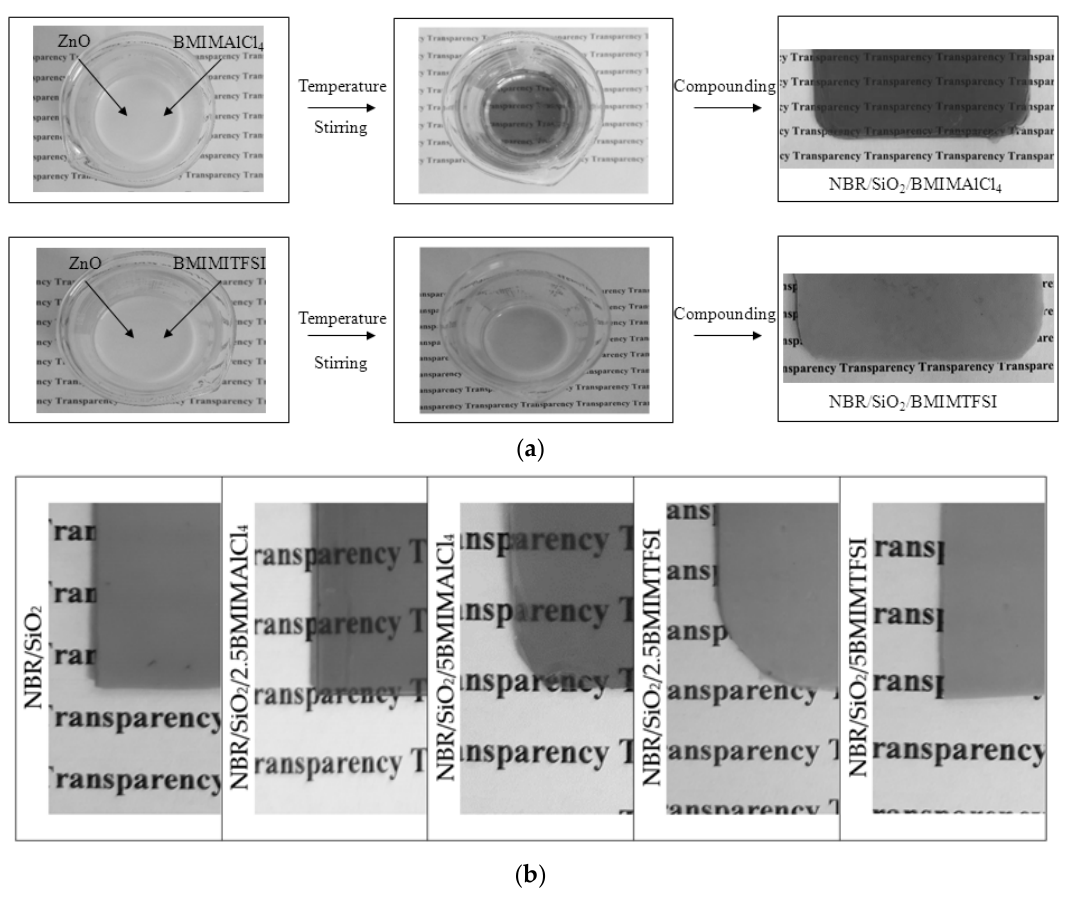
Figure 2. Effect of imidazolium ionic liquids: 1-butyl-3-methylimidazolium tetrachloroaluminate (BMIMAlCl 4 ) and 1-butyl-3-methylimidazolium bis(trifluoromethylsulfonyl)imide (BMIMTFSI) with different anions on the transparency of NBR composites ( a ) and changes of the transparency ( b ). Changes in the colorimetric parameters confirmed that increasing the concentration of BMIMAlCl 4 caused a higher transparency, as can be seen from Table 2. The total color di ff erence ∆ E for composites containing 2.5 and 5 phr of BMIMTFSI showed low values (1.9 and 4.8, respectively) in relation to the NBR / SiO 2 composite. On the other hand, the NBR compounds with BMIMAlCl 4 displayed an ∆ E parameter of about 20, which confirms changes in the color characteristic of NBR / SiO 2 / BMIMAlCl 4 Table 2. Changes in the color parameters of the NBR composite after the addition of ionic liquids at different concentrations.